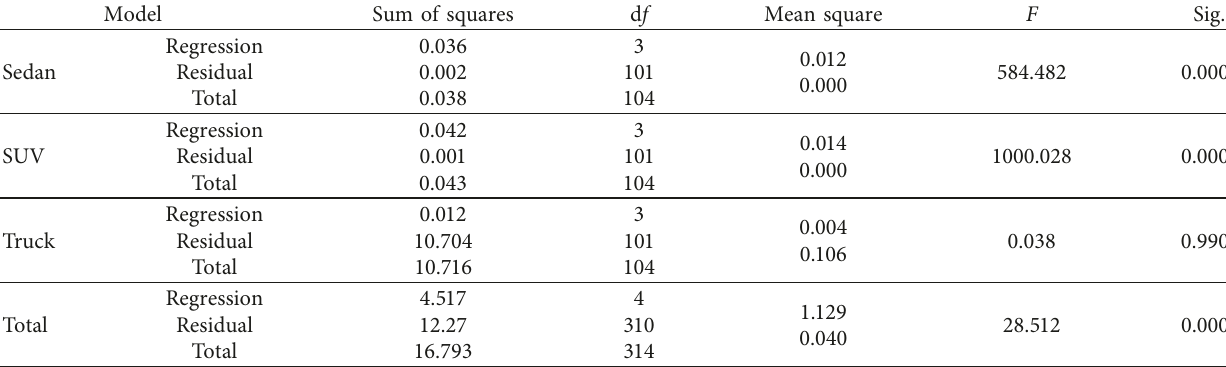
Table 3: ANOVA test results for the lateral acceleration of the design’s vehicles.